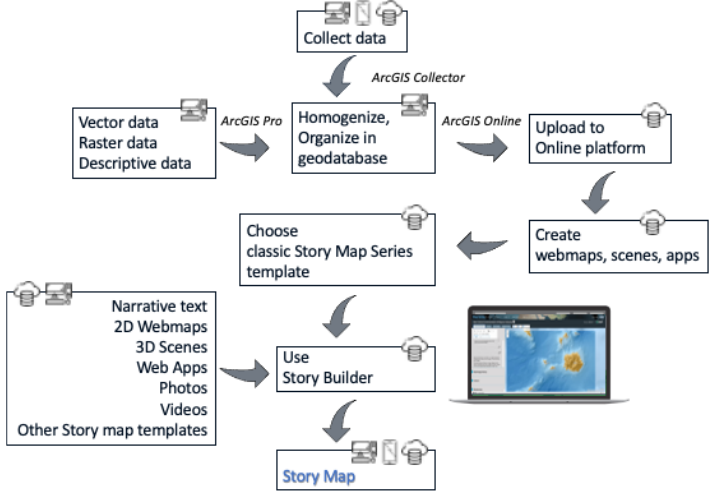
Figure 4. Workflow used in this Story Map.